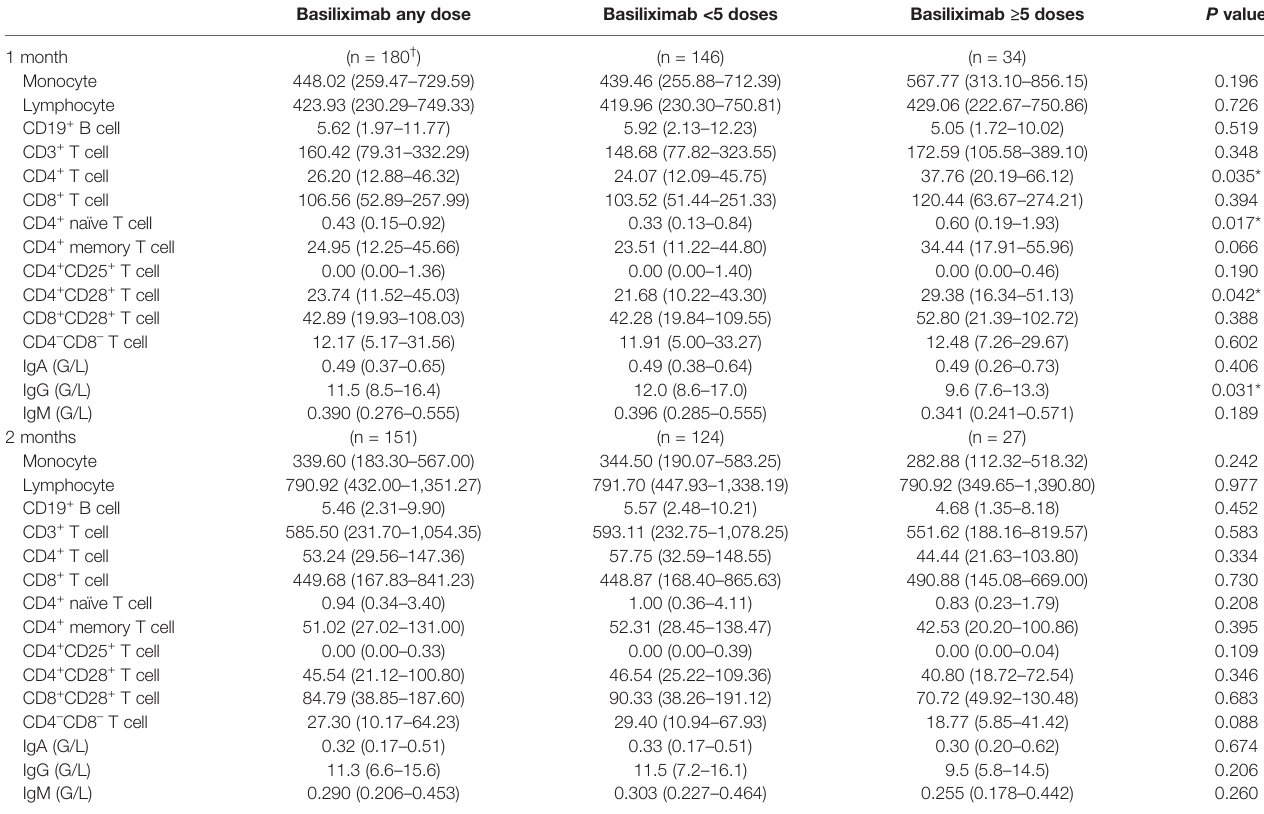
TABLE 2 | The values of immune cell subset counts at 1 and 2 months after HID HSCT [median (25th –